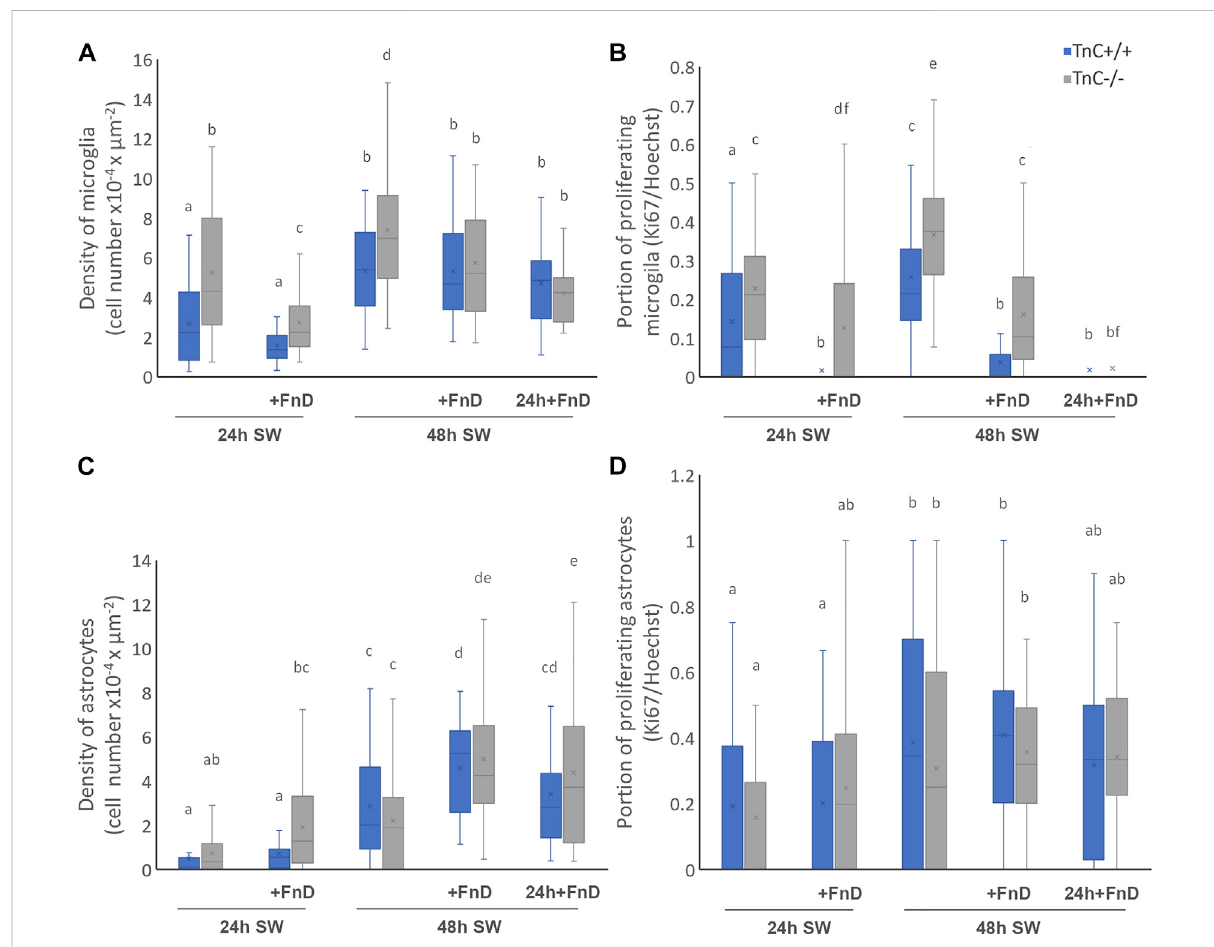
FIGURE 1 FnDreducesmicroglialdensityandproliferation,whereasitincreasesdensityofastrocytesanddoesnotaffecttheirproliferationinthegaparea. Confocal images of cells labelled with immuno fl uorescent markers for microglia, astrocytes, cell nuclei and proliferation, were used for calculations of density and proliferation rates. Box — whisker plots show densities and proliferation rates of microglia [ (A,B) , resp.) and astrocytes [ (C,D) , resp.) in the gap area. Two-way ANOVA was used to test statistical signi fi cance. Pairwise comparisons are denoted with letters, shared letters imply no signi fi cantdifferencebetweengroupsandactual p valuesareindicatedinthetext(No.Images=36,fromthreeindependentcultures,pertreatment, per